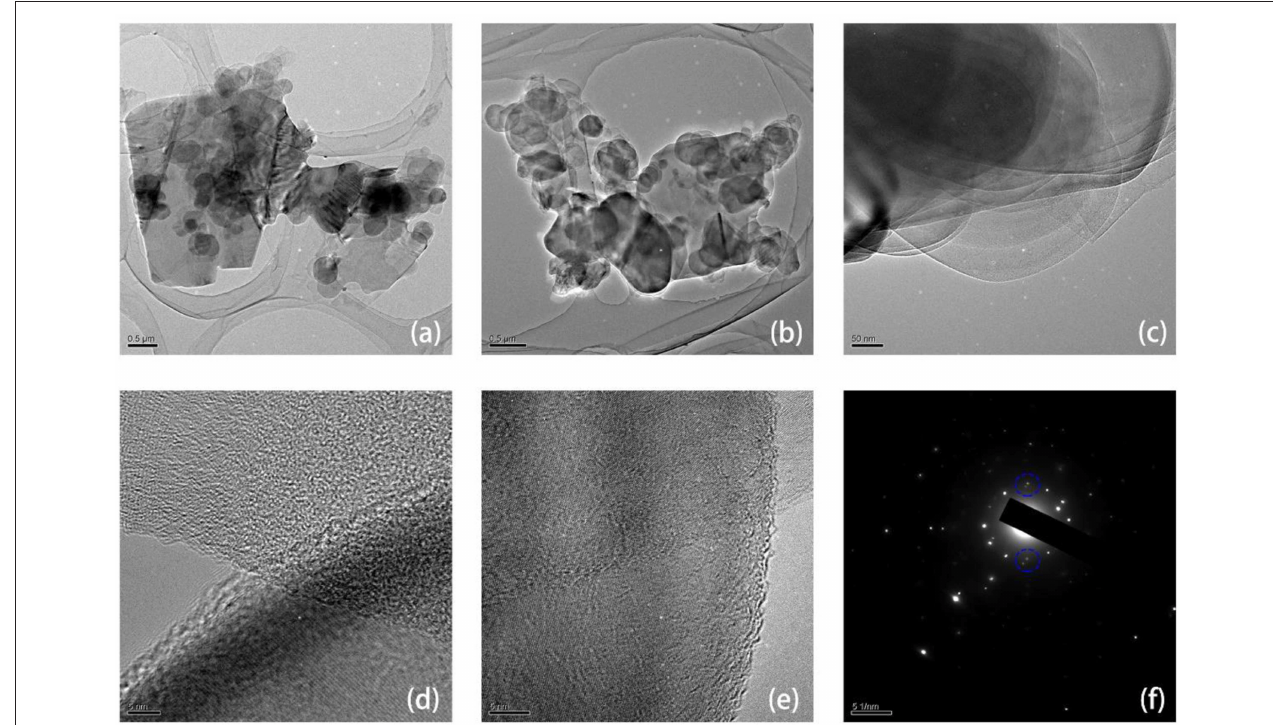
FIGURE 4 | The TEM (a–e) and selected area electron diffraction (SAED) (f) images of h-BN/graphene